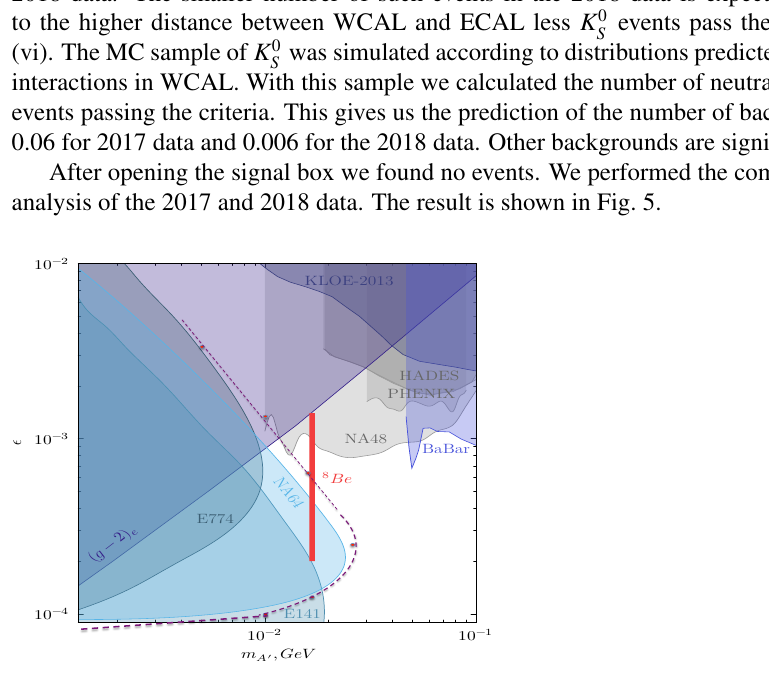
Figure 5. The regions of X → e + e − parameters excluded by the NA64 experiment with the 2017 data (blue shadowed region) and with 2017 + 2018 data (dashed line, preliminary). The red vertical line is the region of parameters that could explain the 8 Be